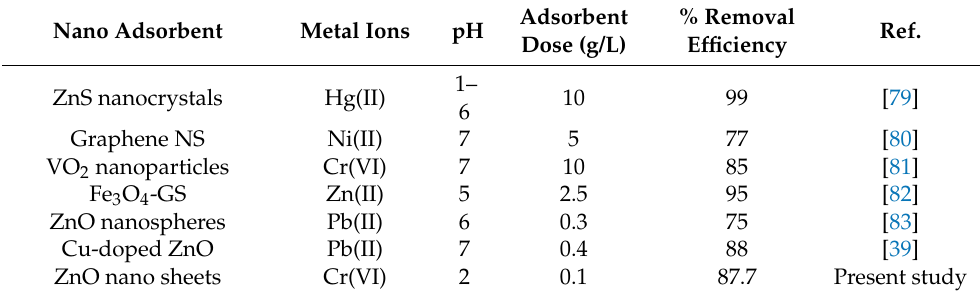
Table 3. The adsorption properties of ZnO NSs compared with other adsorbent